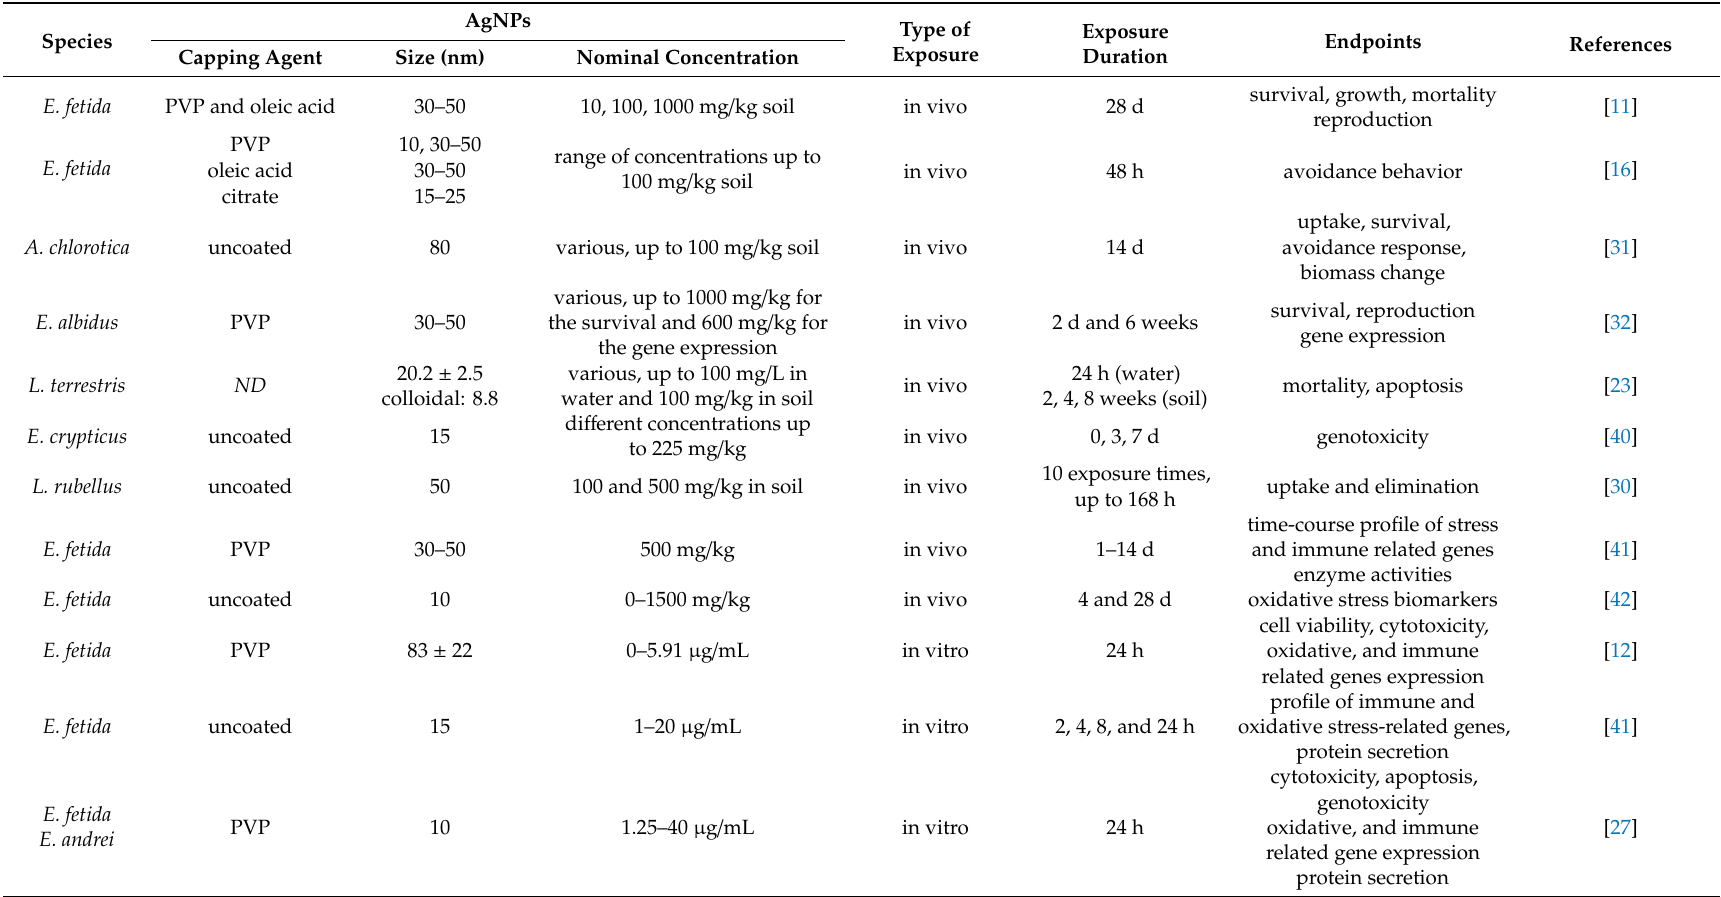
Table 1. Summary of toxicological studies of AgNPs in di ff erent earthworm